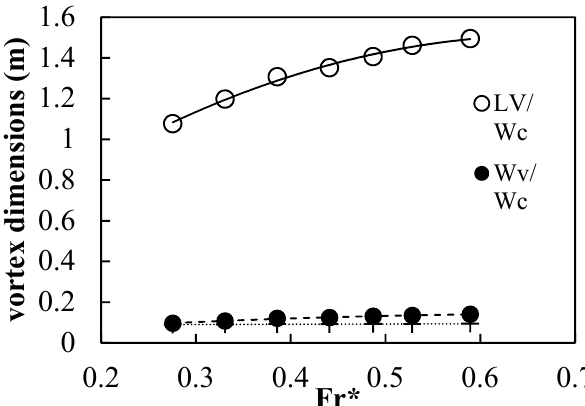
= 8.35 (x = 0.5 Wc downstream of